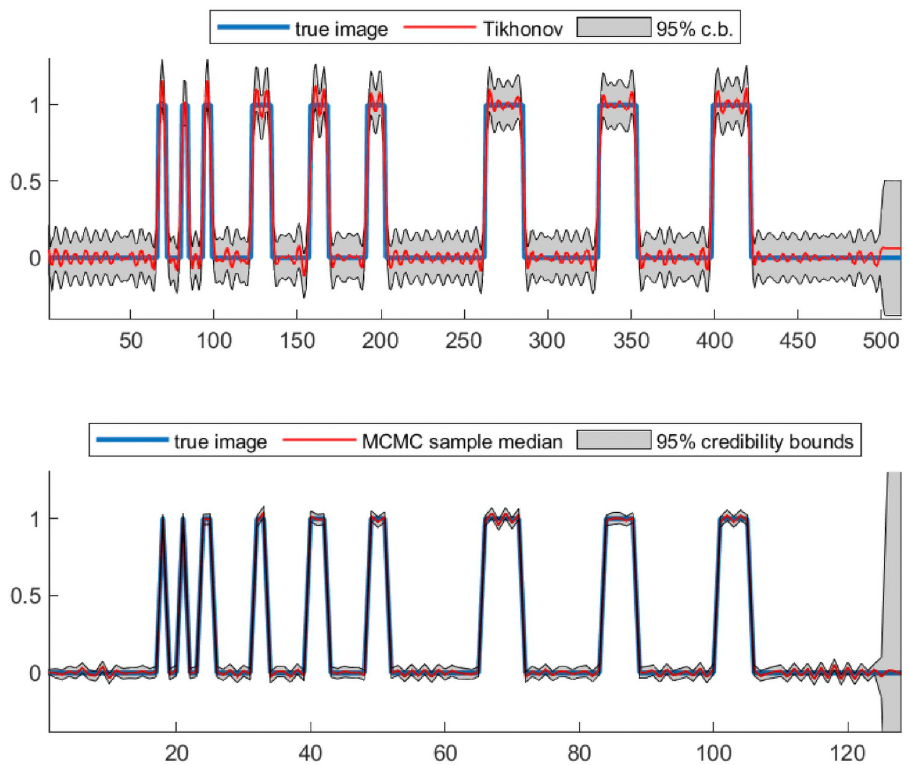
Fig 6. Uncertainty quantification for linear respirometry. The top plot contains the Tikhonov- Q solution with the 95% credibility bounds, and the bottom plot contains the sample median and 95% credibility bounds with 1000 samples corresponding to the Laplace prior.